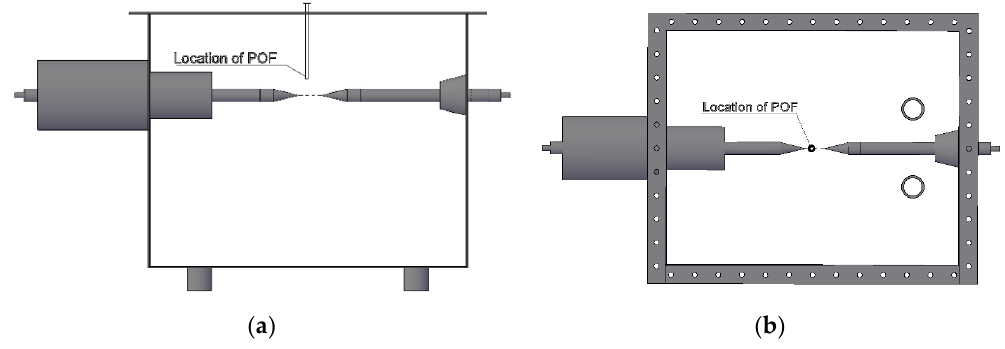
Figure 2. Needle–needle electrode system: schematic diagram side view ( a ) and view from above ( b ).